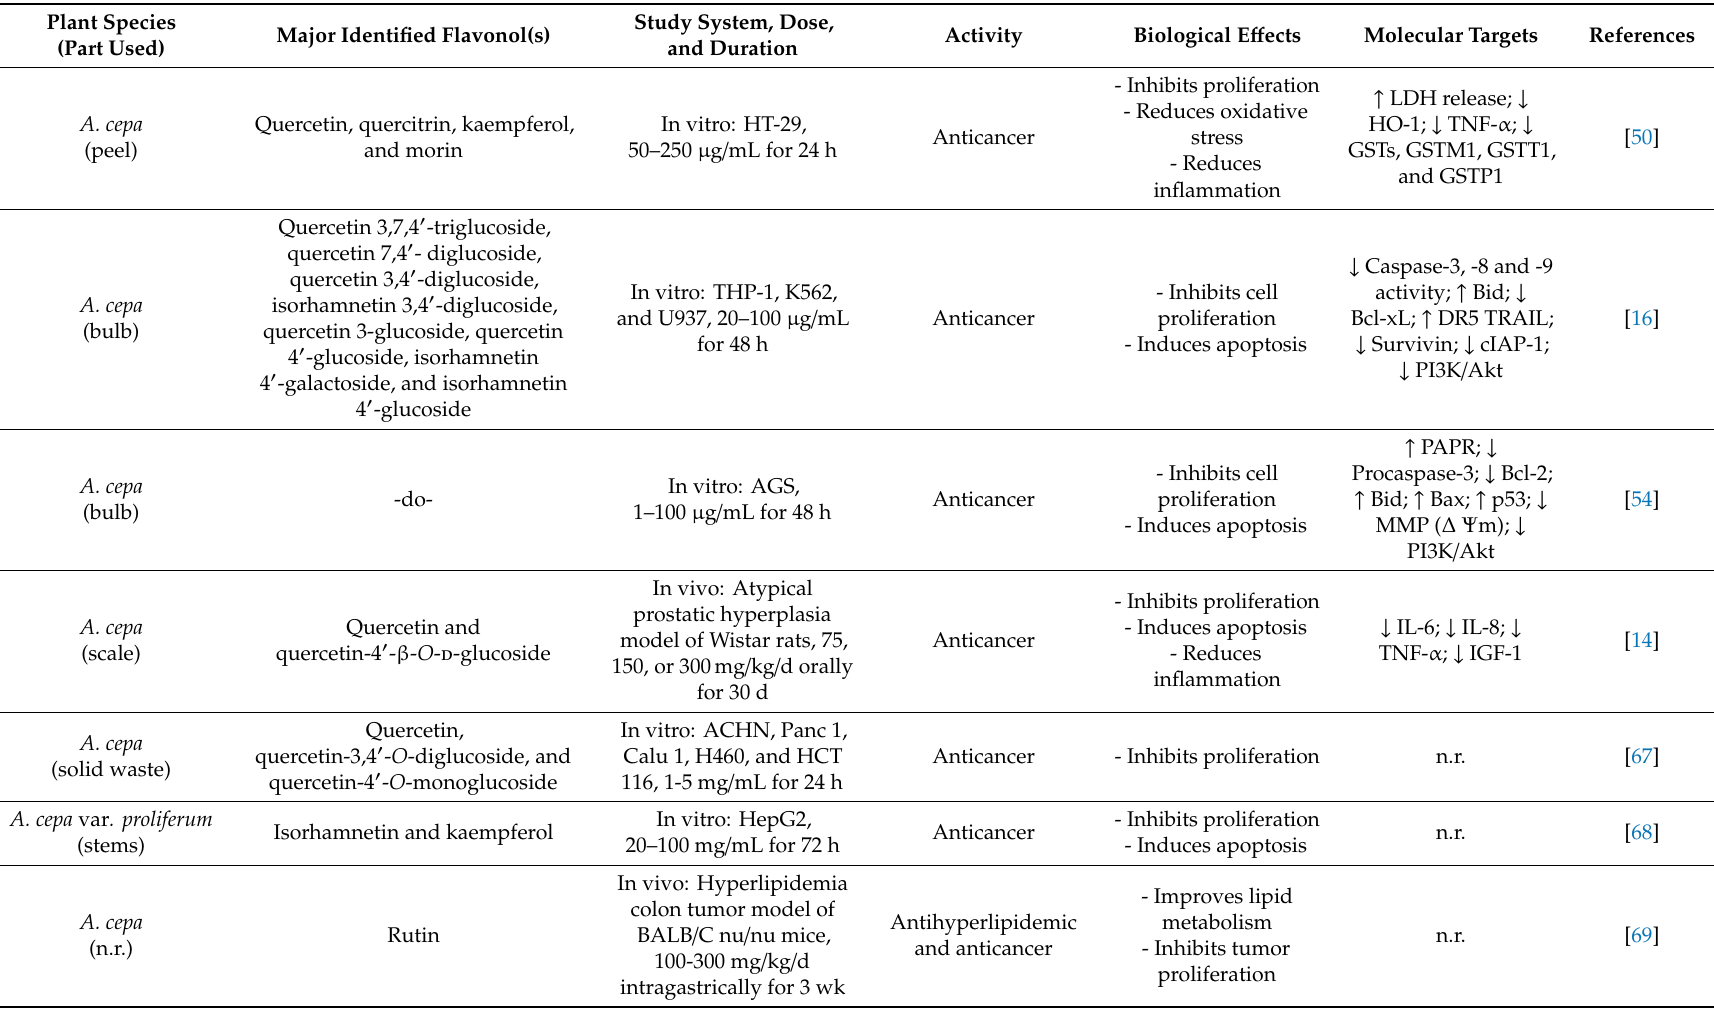
Table 3. Allium derived flavonols for chronic disease prevention in pe-clinical and clinical